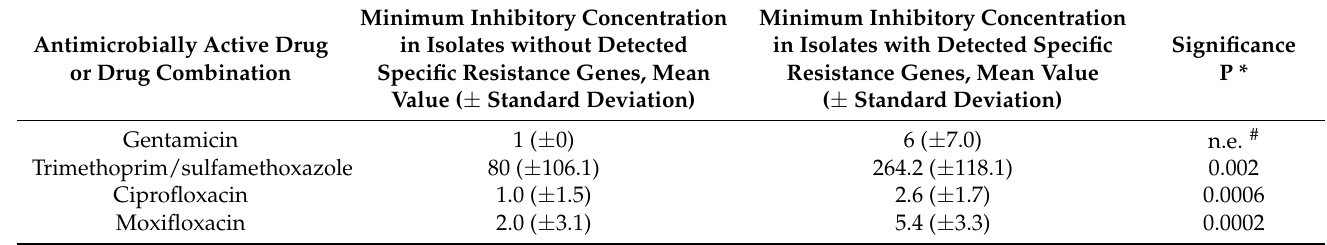
Comparison of minimum inhibitory concentrations for gentamicin, trimetho- prim/sulfamethoxazole, ciprofloxacin, and moxifloxacin measured with isolates with and without detected specific resistance genes. To allow calculation with the measured values, “ ≤ ” and “ ≥ ” symbols were